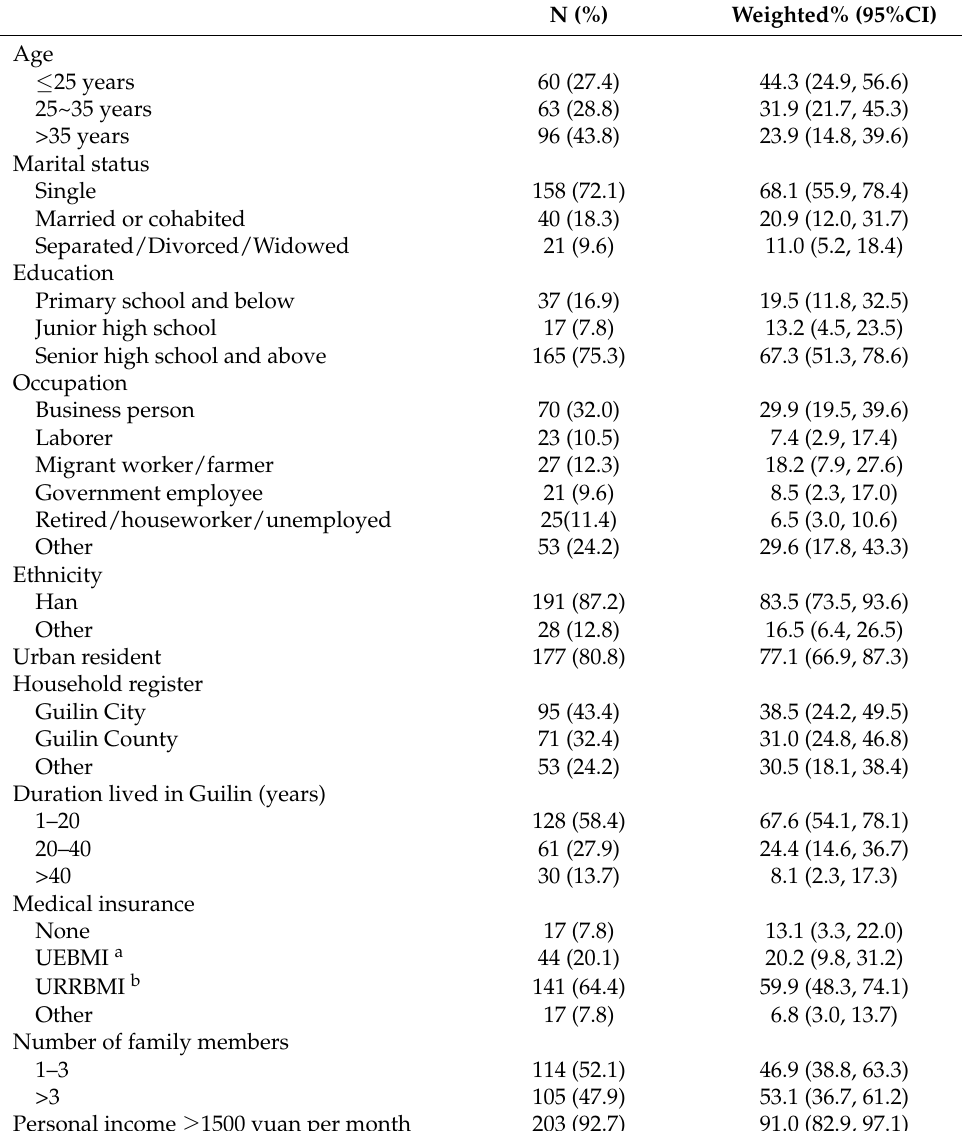
Table 1. Crude and adjusted characteristics among men who have sex with men in Guilin, China ( n =